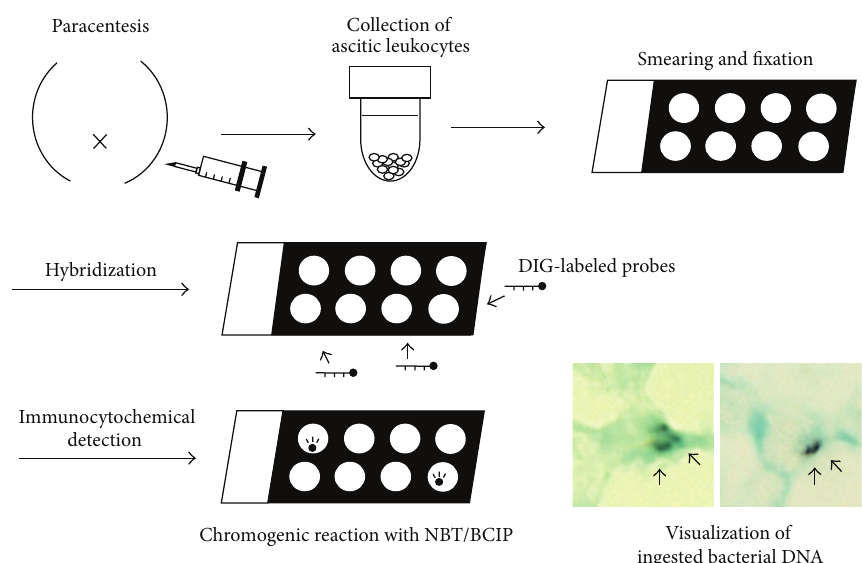
Figure 2: Schematic representation of the in situ hybridization (ISH) method used to assess the ascitic samples. Floating leukocytes in the ascitic fluid were collected via centrifugation and used for the ISH tests. DIG- (digoxigenin-) labeled probes were used for hybridization, and positive signals were detected with NBT (nitro-blue tetrazolium chloride) and BCIP (5-bromo-4-chloro-3 󸀠 -indolyphosphate p-toluidine salt). Positive (purple brown) signals were observed in the leukocytes with intracellular bacterial DNA